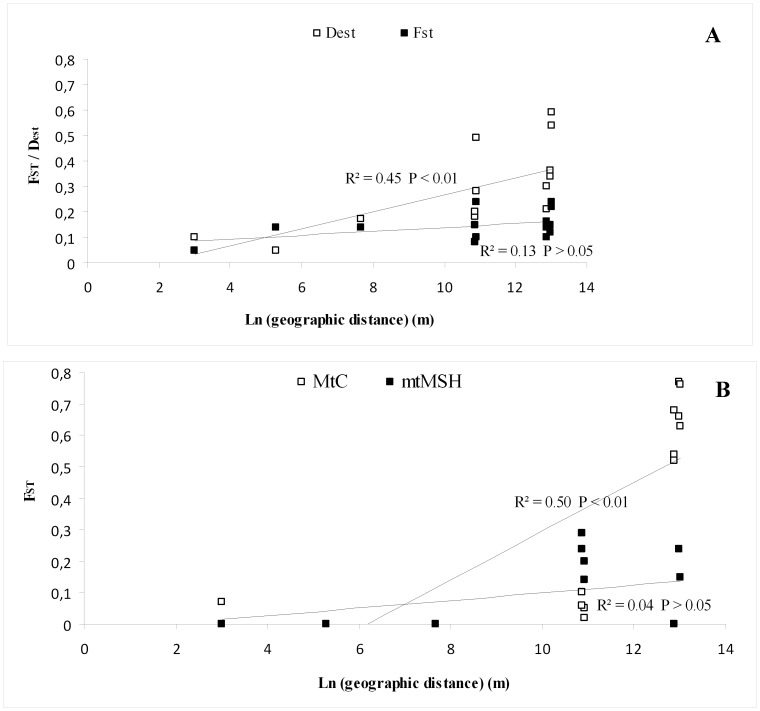
Relationship between genetic differentiation estimates and the logarithm of geographical distance among Corallium rubrum populations.A) relationship between genetic differentiation estimates (FST and Dest) and the logarithm of geographical distance for microsatellites markers. B) relationship between genetic differentiation estimates and the logarithm of geographical distance for both mtMSH and mtC markers.